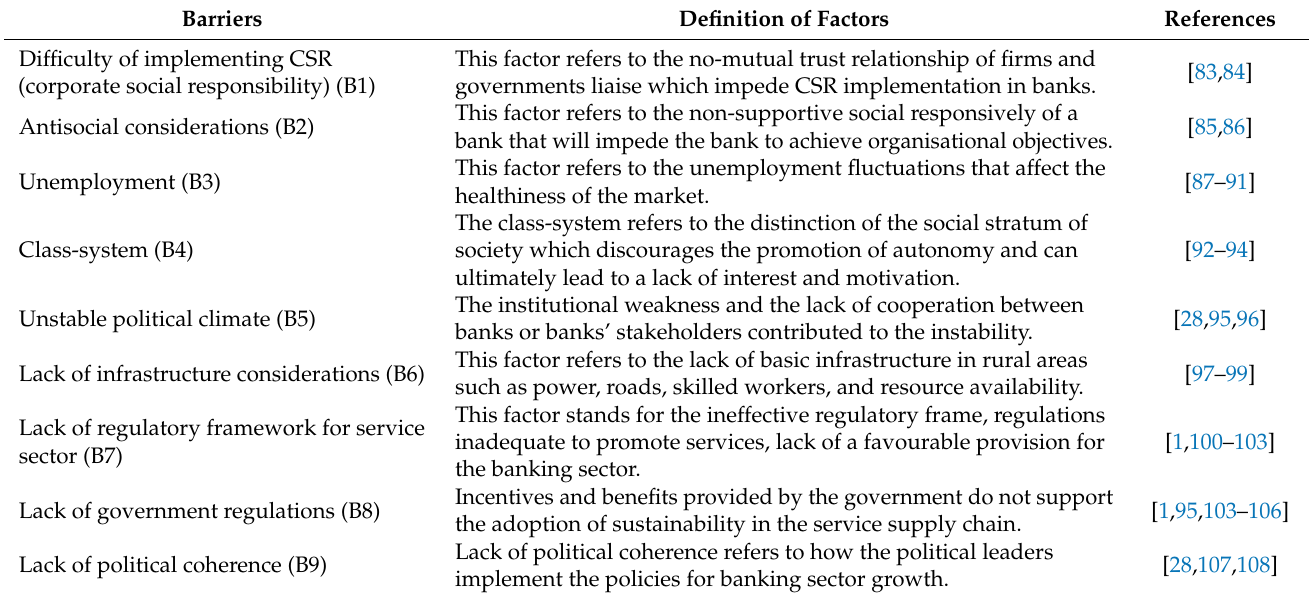
Table 2. Barriers to socio-political